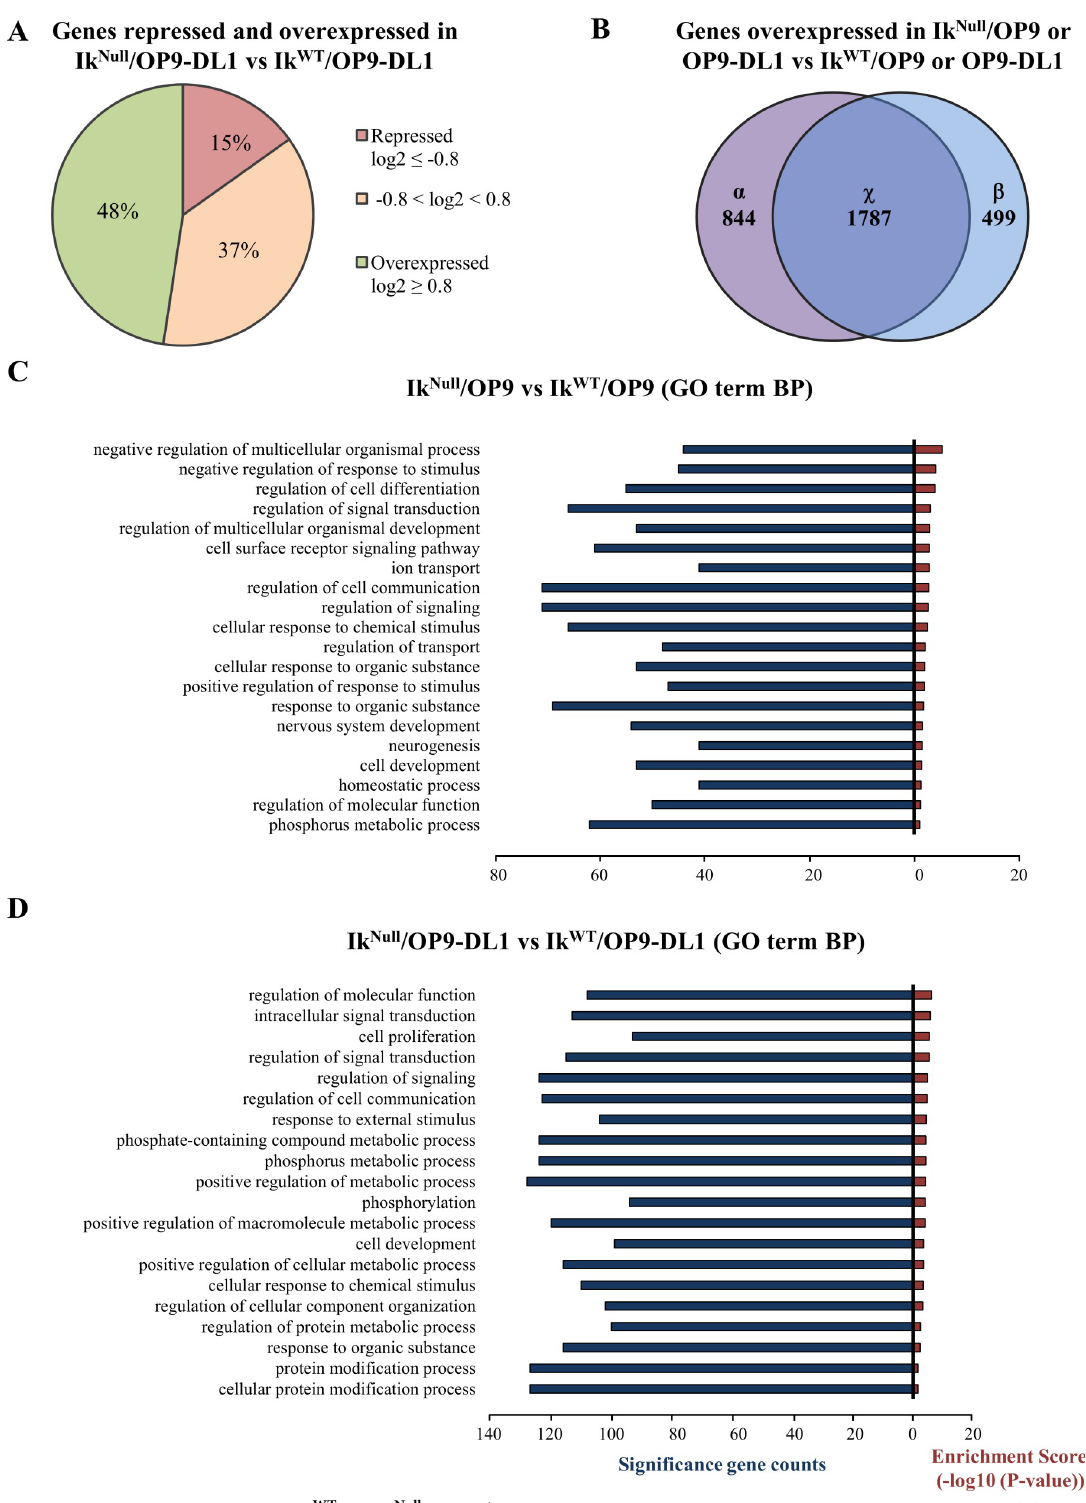
Fig 1. RNA-sequencing analysis of Ik WT and Ik Null Ter119 + cells upon IKAROS ablation and NOTCH pathway activation. (A) Circular diagram depicting repressed (red) or overexpressed (green) genes in Ik Null /OP9-DL1 compared to Ik WT /OP9-DL1 cells (log2 � 0.8 or � -0.8; FDR < 0.05; p < 0.05). (B) Venn diagram summarizing the overlap between overexpressed genes (log2 � 0.8) in Ik Null vs Ik WT Ter119 + cells co-cultured with OP9-DL1 ( α ; left circle) or OP9 ( β ; right circle) cells; the number of genes called by both